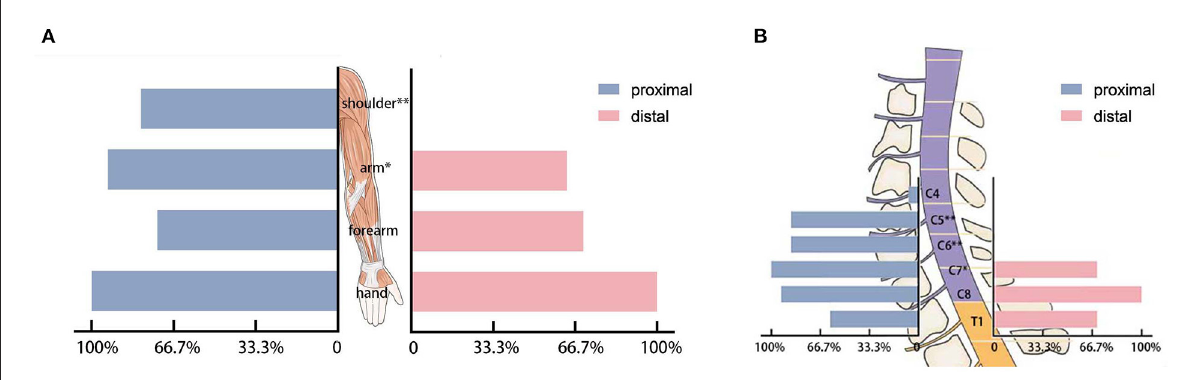
FIGURE3 (A) The affected muscle groups in electromyography. (B) The affected cervical segments in electromyography. * p < 0.05 and ** p <